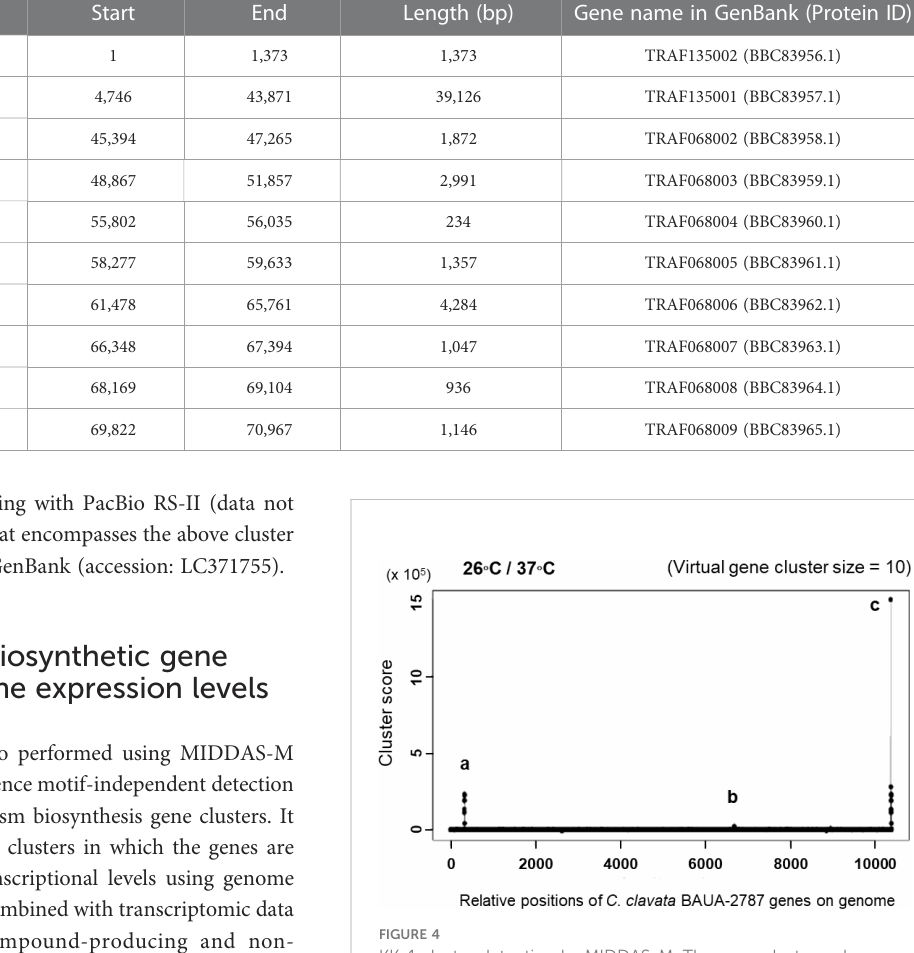
FIGURE 4 KK-1 cluster detection by MIDDAS-M. The gene clusters whose expression levels increased at 26 ˚ C, the KK-1-producing culture temperature condition, when compared to 37 ˚ C, the non- producing culture temperature condition. The analysis was performed on the data that consisted of the manually connected sequence of the putative KK-1 cluster, which was presumed to have been fragmented into three sequences (see Figure 3) and is at the end of all the obtained gene data at the right end of the horizontal axis. The three detected peaks are indicated by (A – C , (A) , a fragmented KK-1 cluster containing Ccnps4 ; (B) a fragmented KK-1 cluster containing Ccnps2 ; and (C) a manually connected KK-1 cluster of the three